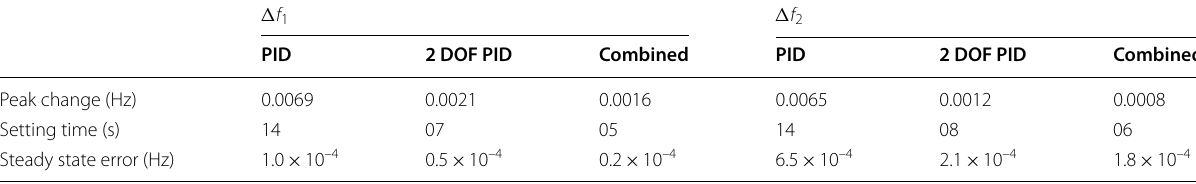
Table 4 Comparison of performance specifications during increasing mode of wind